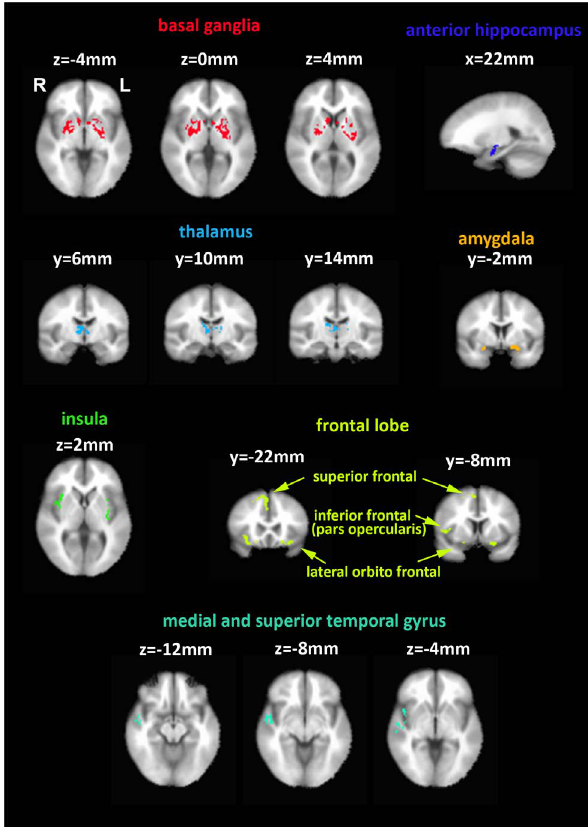
Figure 2. Whole brain map highlighting regions of significant correlation (p , 0.05, corrected for multiple comparisons using AlphaSim in AFNI, minimum cluster size =258 voxels) between BOLD signal variability and performance scores across sub- jects.